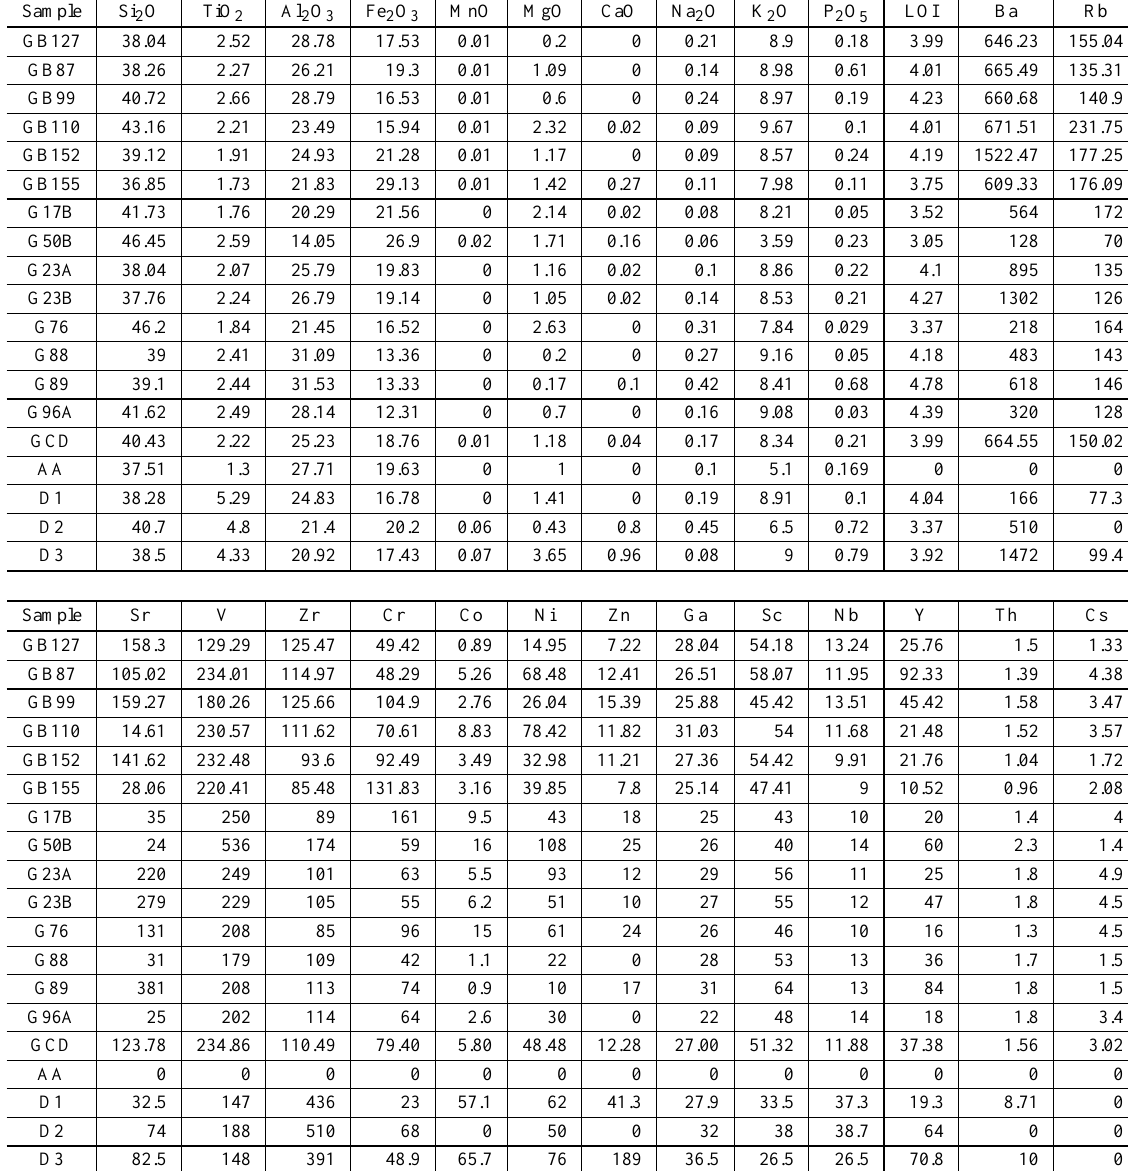
Table of geochemical analyses of martite-muscovite dikes and sill samples from Chapada Diamantina–BA. Major elements (wt %) were analyzed by ICP-OES, trace and REE elements (in ppm) by ICP-MS at Act Labs in Canada. For comparison are included chemical analyses of hematitic philite from Diamantina – MG. The samples AA – (after Almeida-Abreu et al. 2005) and D1, D2 and D3 (after T.M.Dussin, unpublished data). The sample GCD is the average for all samples from Chapada Diamantina – BA. x – not analyzed; n.d. – not